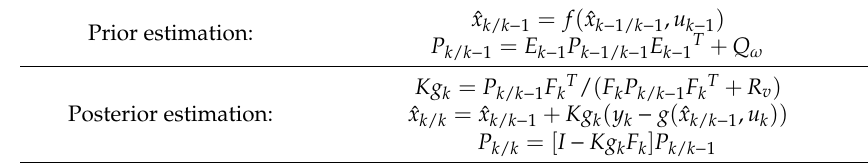
Table 8. The extended Kalman filter (EKF) algorithm recursive